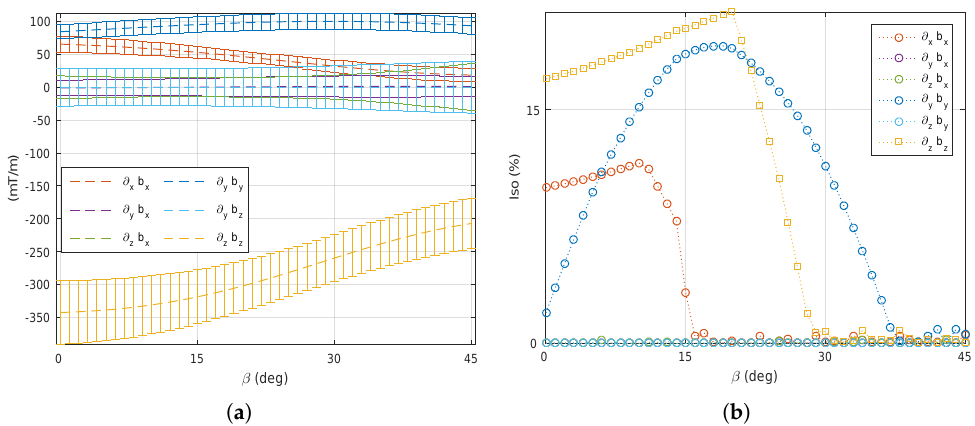
Figure 20. One mobile electromagnet (coil 5) is rotating, and others are fixed to β = 14°: ( a ) the average and ( b ) the uniformoty of magnetic gradients.